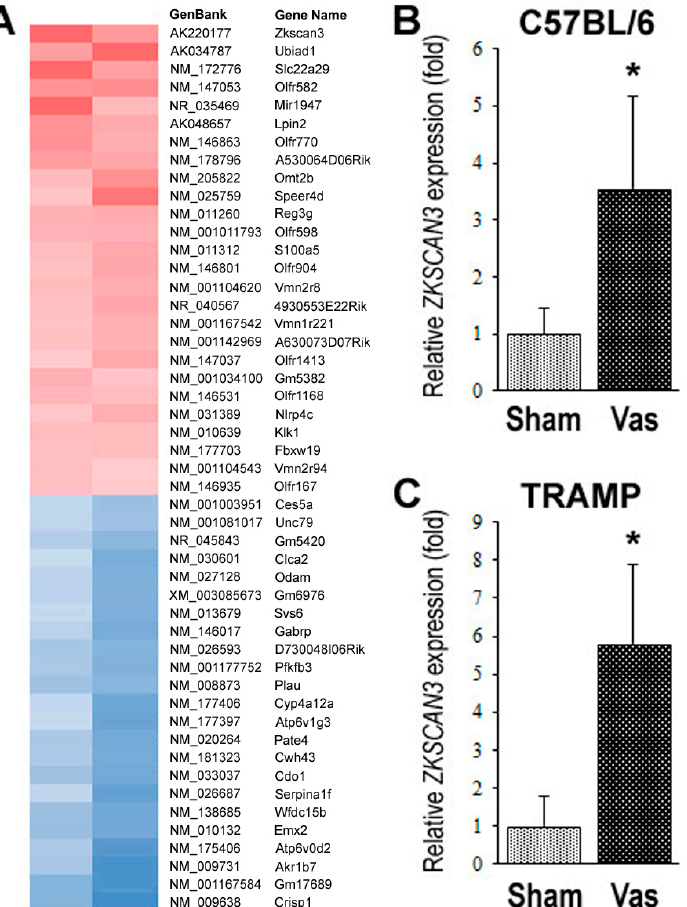
Figure 2. Identification of ZKSCAN3 as the one whose expression is significantly altered by vasectomy. ( A ) Gene expression was systematically compared by DNA microarray in prostate tissues from two pairs of 24-week-old male C57BL/6 mice undergoing sham surgery vs. vasectomy at 10 weeks of age. Red/blue = up/down-regulated genes, respectively, in vasectomized mice. Actual microarray data have been deposited in the NCBI Gene Expression Omnibus (GEO; http://www.ncbi.nlm.nih.gov/geo/) and are accessible through GEO Series Accession number GSE54003. Quantitative real-time RT-PCR for ZKSCAN3 , using prostate tissues from 5 pairs of 24-week-old male C57BL/6 mice undergoing sham surgery vs. vasectomy at 10 weeks ( B ) or 8 pairs of 24-week-old male TRAMP mice undergoing sham surgery vs. vasectomy at 4 weeks ( C ). The expression of ZKSCAN3 gene was normalized to that of GAPDH , and transcription amount representing the mean ( + SD) is presented relative to that in the sham / control group. * p < 0.01 (vs.